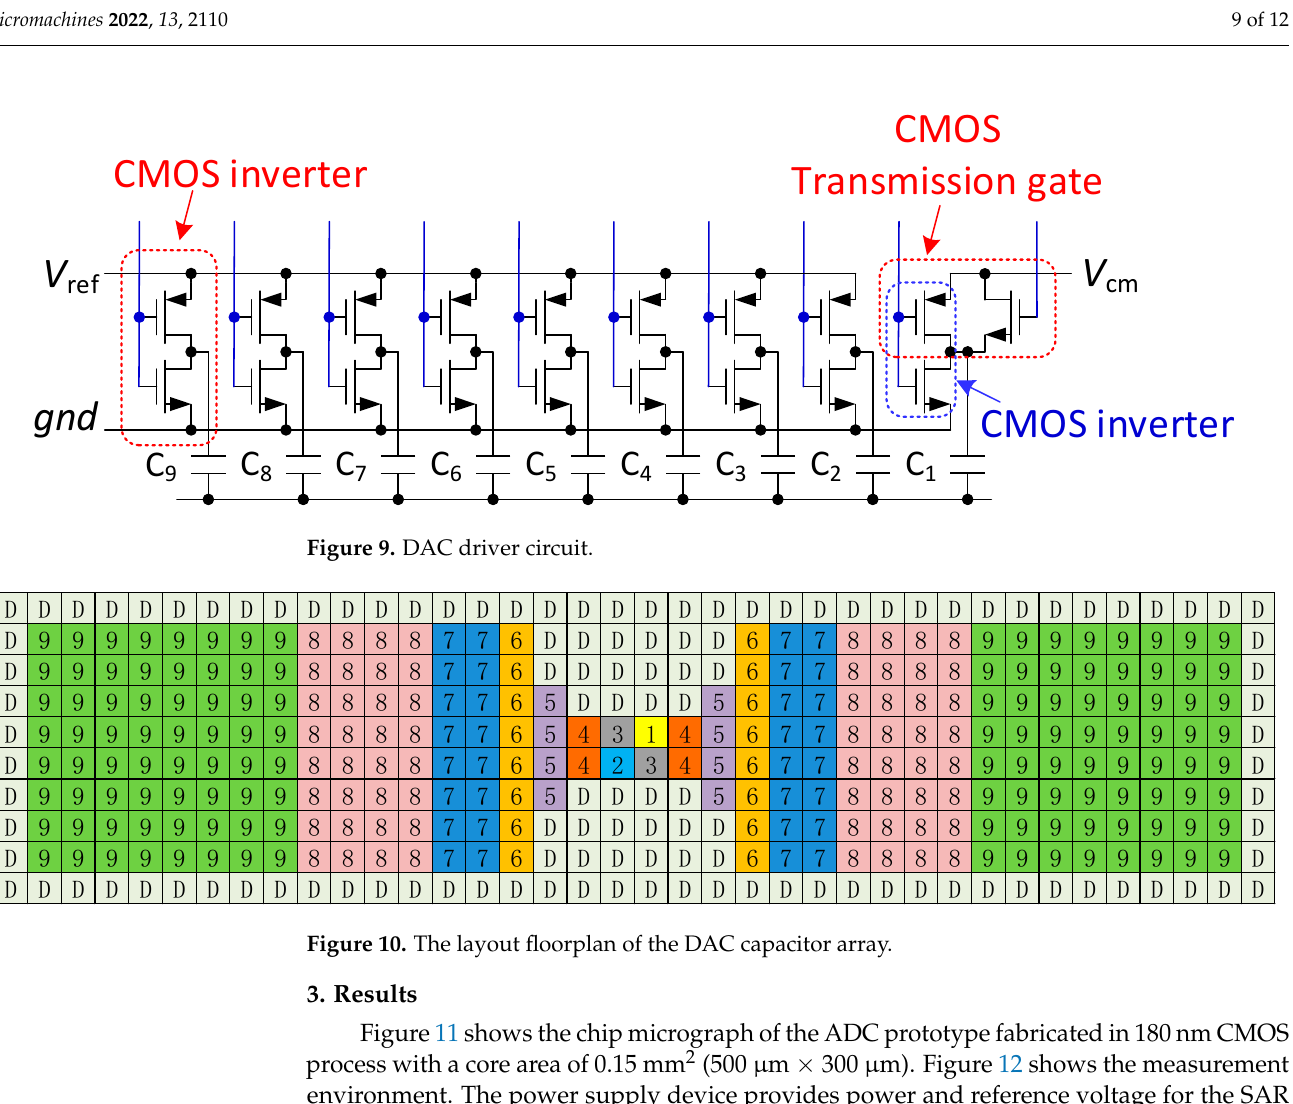
Figure 10. The layout floorplan of the DAC capacitor array.